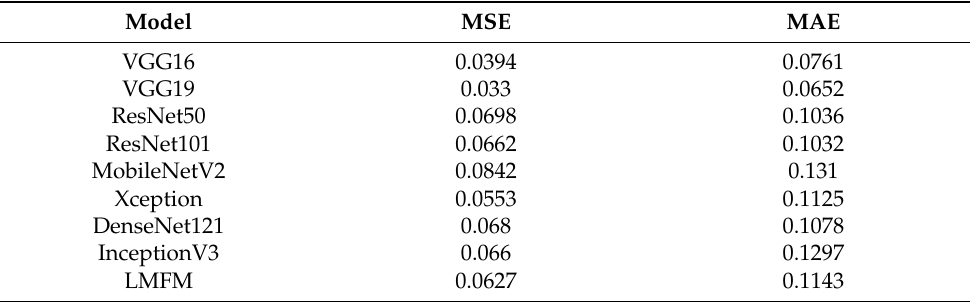
Figure 8. The results for the FPS when the deep learning model was running on the onboard computer. Table 2. Model performance comparison when performing on the onboard